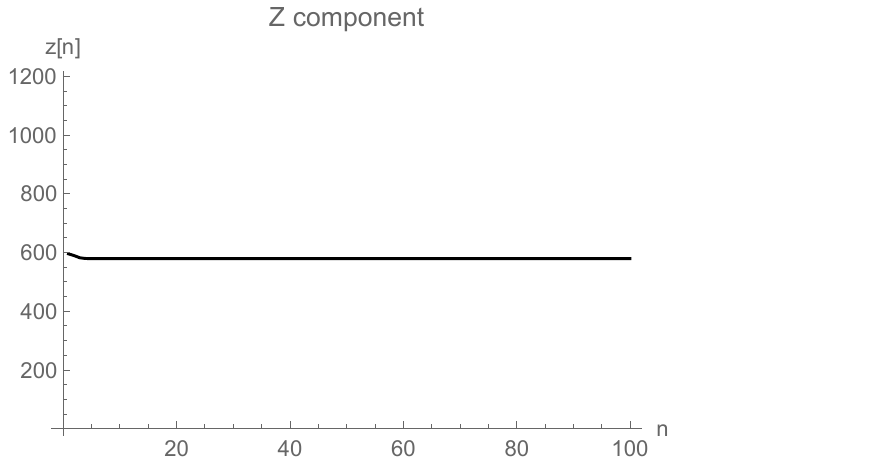
Figure 3. Graph of z n for α = 167, β = 0.01, γ = 0.03, δ = 0.4, ζ = 155, η = 0.05, µ = 0.05, ε = 0.3, υ = 144, ρ = 0.03, σ = 0.08, ω = 0.2. with initial conditions x 0 = 10.0, y 0 = 20.0 and z 0 = 25.0.